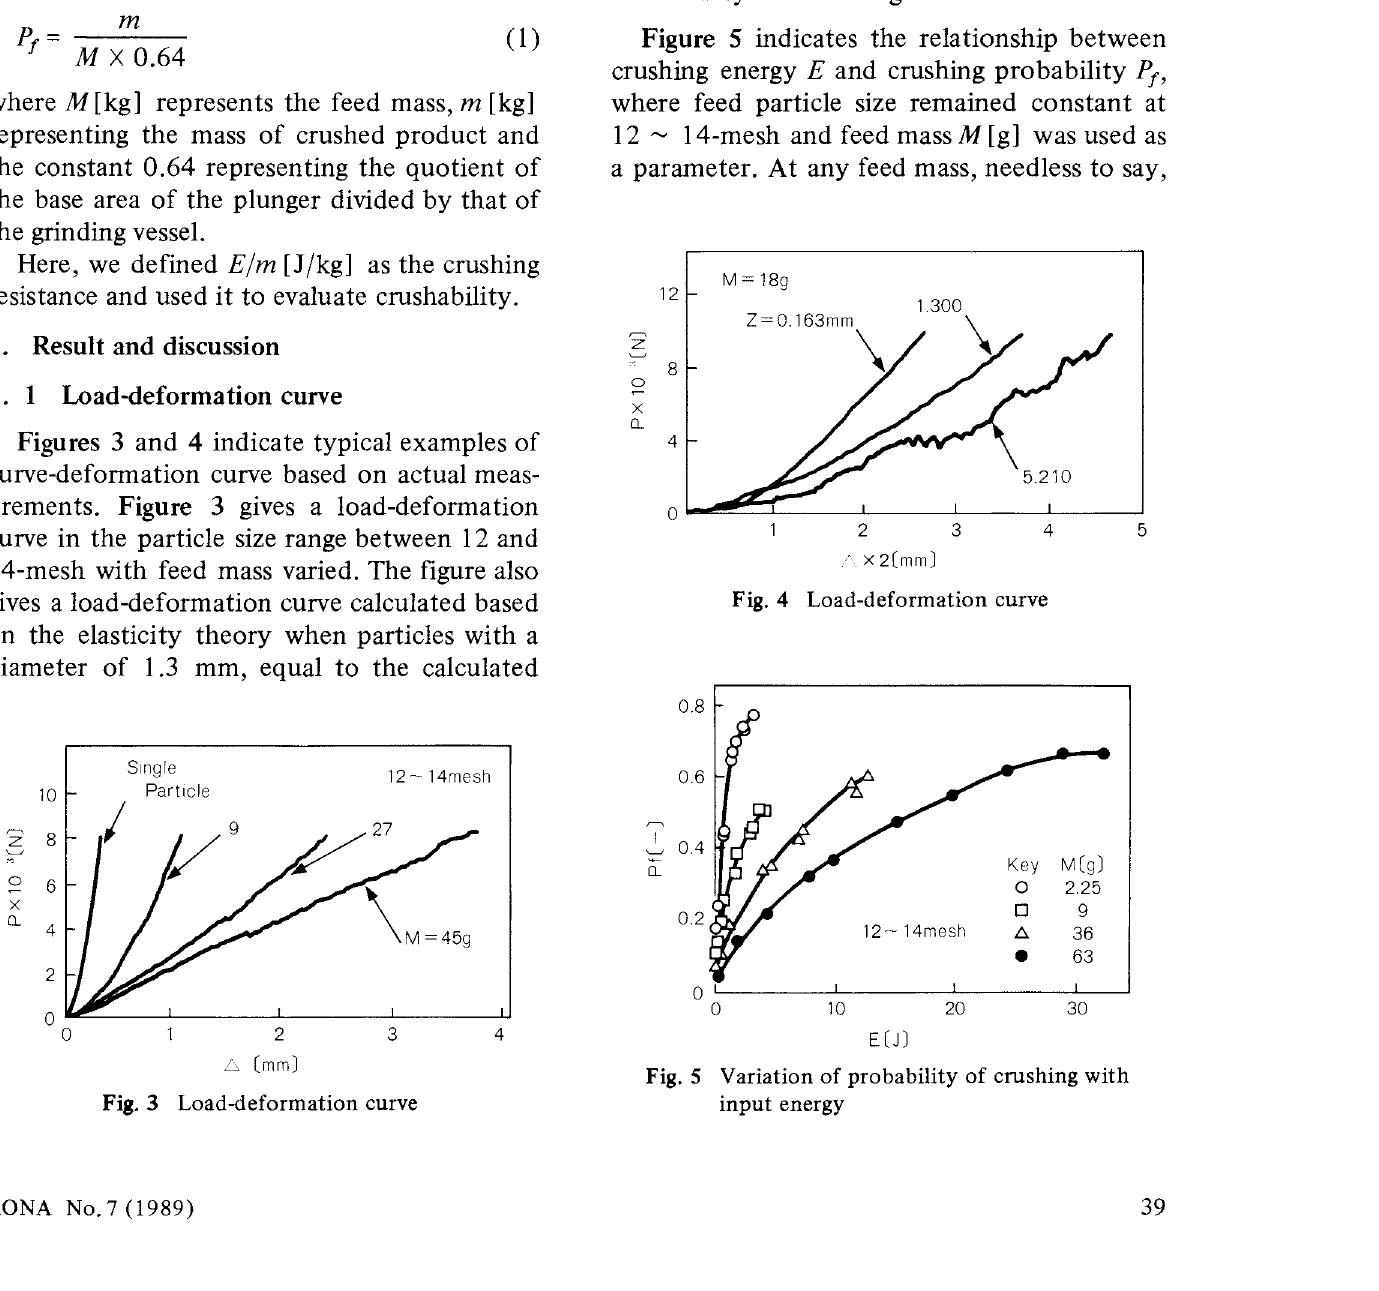
Fig. 5 Variation of probability of crushing with input